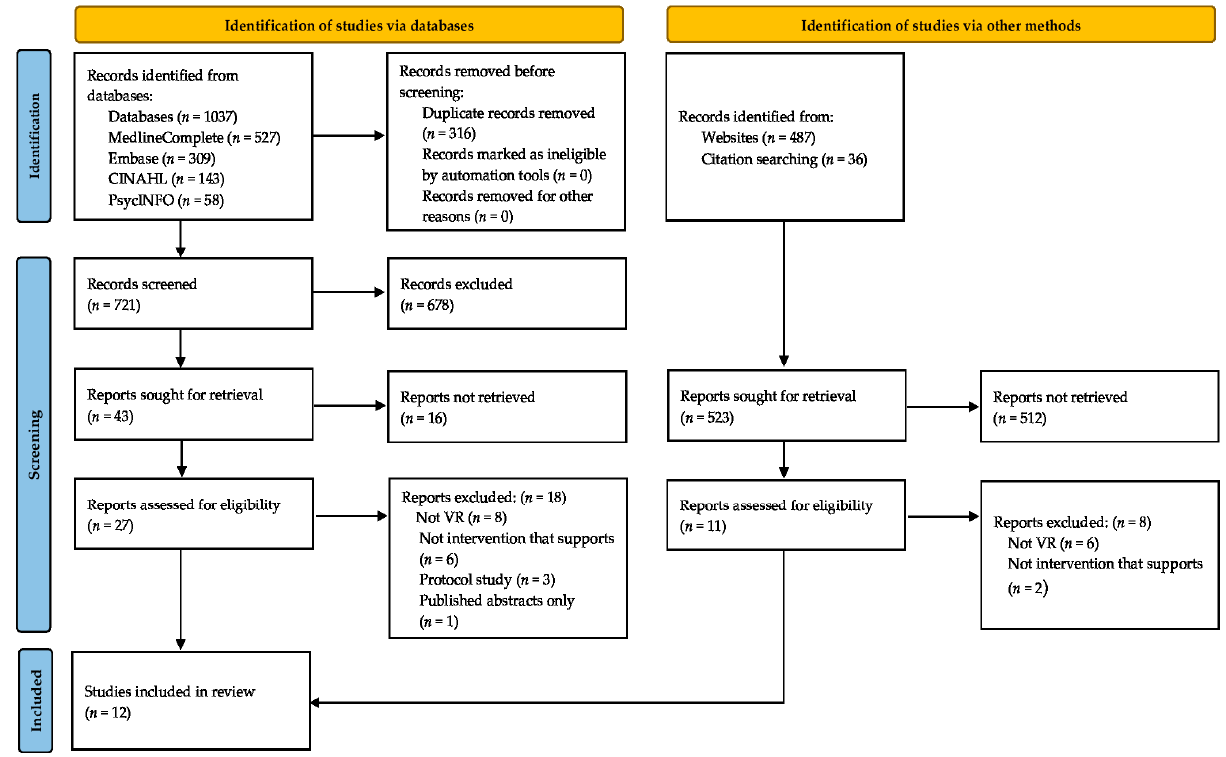
Figure 1. The Preferred Reporting Items for Systematic Reviews and Meta-Analyses (PRISMA) flow chart. VR: virtual reality; HM: home modification.